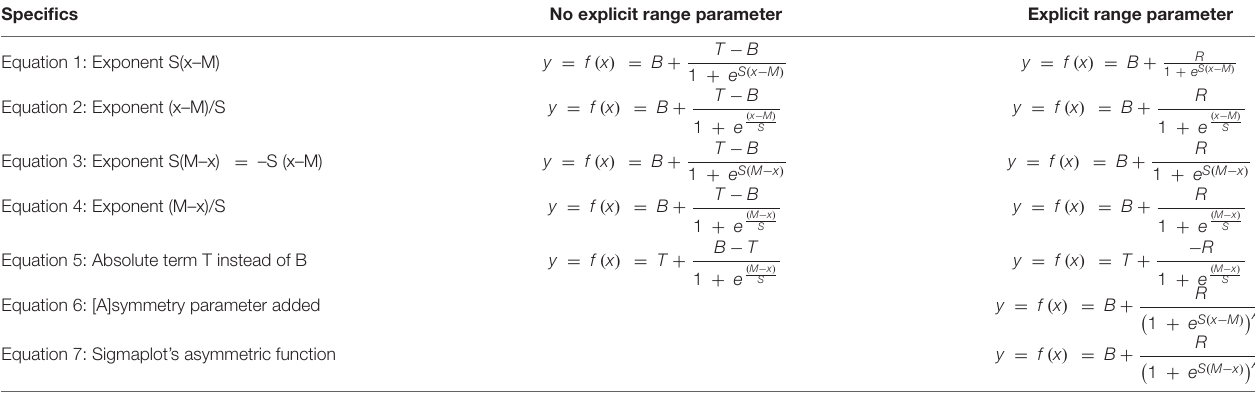
TABLE 1 | Versions of 4- and 5-parameter Boltzmann sigmoidal equations. Specifics No explicit range parameter Explicit range parameter